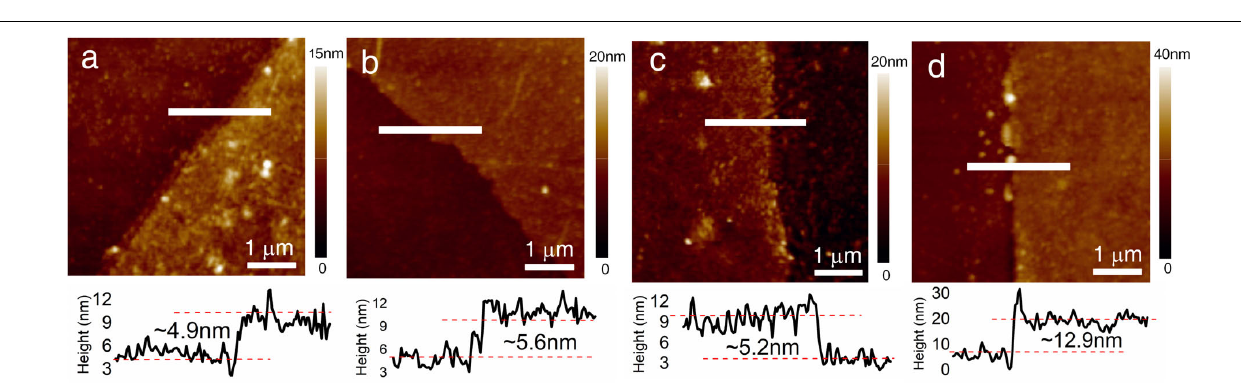
FIGURE 4 | The AFM images of graphene hybrid with different BLUF. (a) Self-assembled monolayer of BLUF- K 1 . The thickness is approximately 4.9 nm when measured along the horizontal white line in AFM image. (b) Self-assembled monolayer of BLUF- K 5 . The thickness is approximately 5.6 nm when measured along the horizontal white line in AFM image. (c) Cross-linking of BLUF-K 1 . The thickness is approximately 5.2 nm when measured along the horizontal white line in AFM image. (d) Cross-linking of BLUF-K 5 . The thickness is approximately 12.9 nm when measured along the horizontal white line in AFM